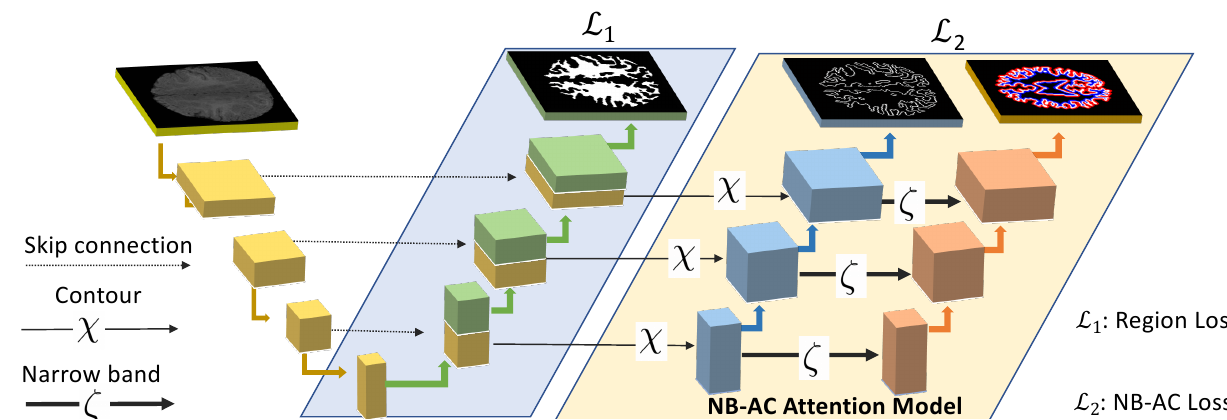
Figure 6. Proposed two-branch network architecture with the NB-AC attention model. The first branch focuses on higher level features with region information. The second branch, the NB-AC attention model, focuses on lower level features with boundary and a narrow band around the